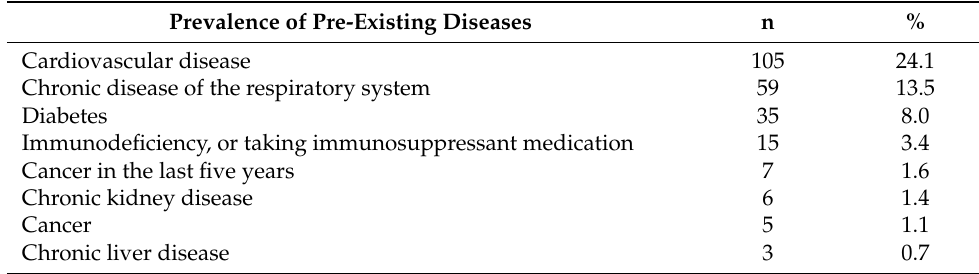
Table 1. Prevalence of pre-existing diseases in the sample by disease. Prevalence of Pre-Existing Diseases n % Cardiovascular disease 105 24.1 Chronic disease of the respiratory system 59 13.5 Diabetes 35 8.0 Immunodeficiency, or taking immunosuppressant medication 15 3.4 Cancer in the last five years Chronic kidney disease Cancer Chronic liver